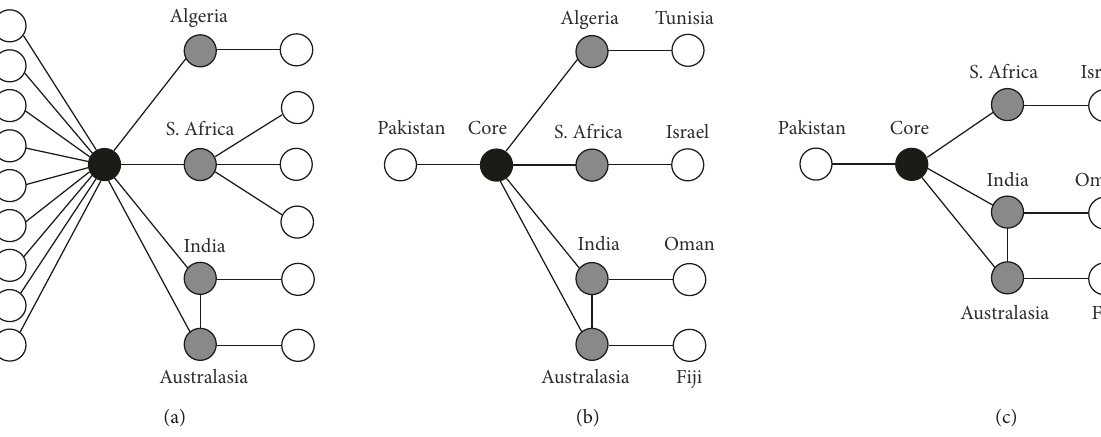
to the criteria given in Definition 19. The core is composed of the East and Southeast Asian countries together with Australia and New Zealand, whereas the semiperiphery is composed of three countries (Algeria, South Africa,